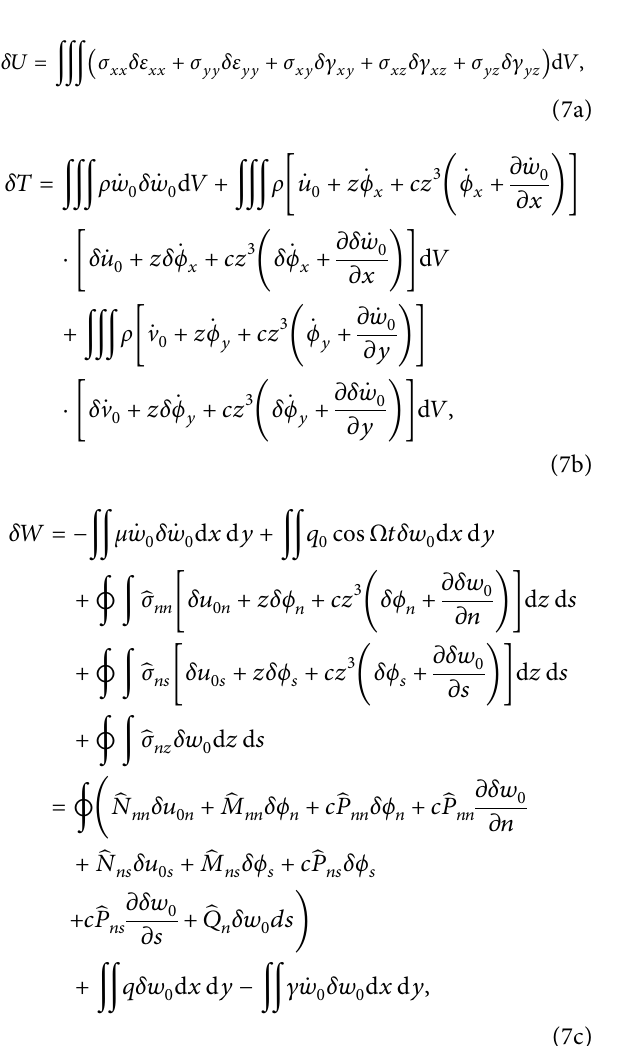
Figure 1: Mechanical model of a composite rectangular laminated